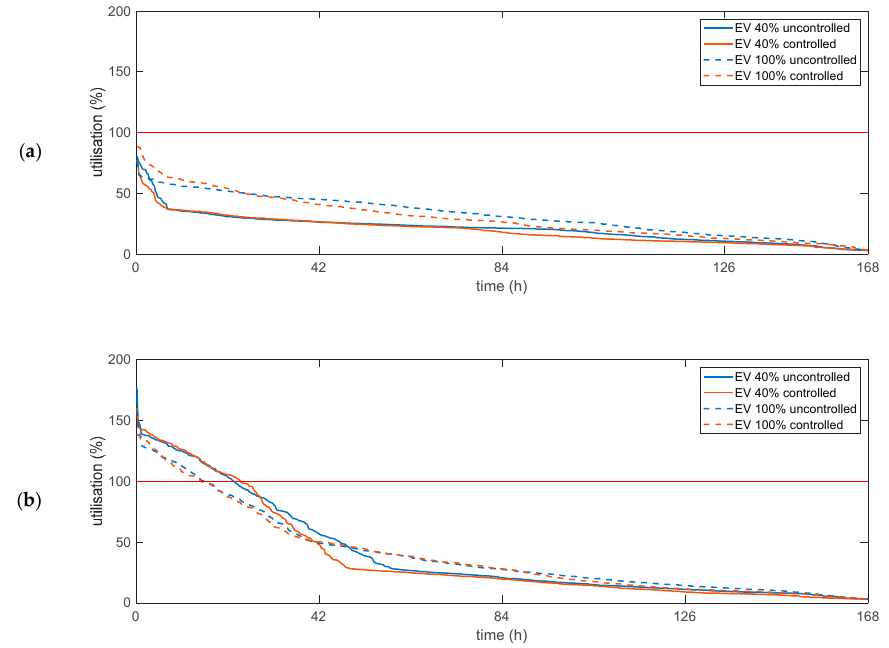
Figure 17. Sorted duration curve of the utilisation of line 1 at a fixed penetration of 60% PV and 3.7 kW charging power for the selected worst-case weeks ( a ) winter ( b ) summer.